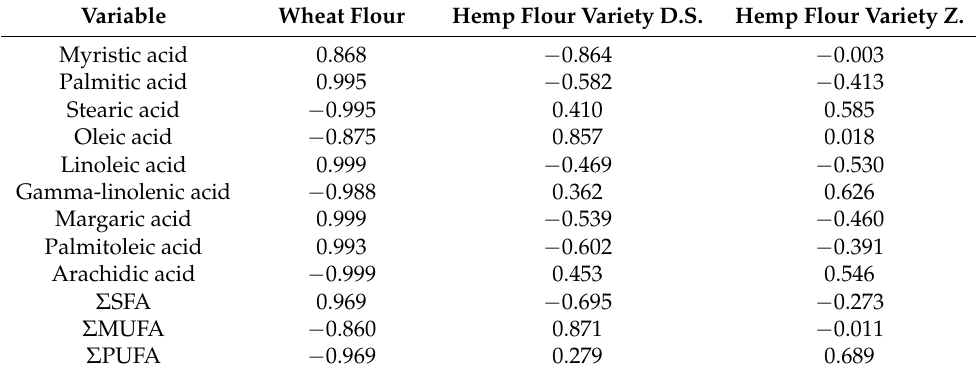
Table 6. Pearson correlation for fatty acids of flour sample. Variable Wheat